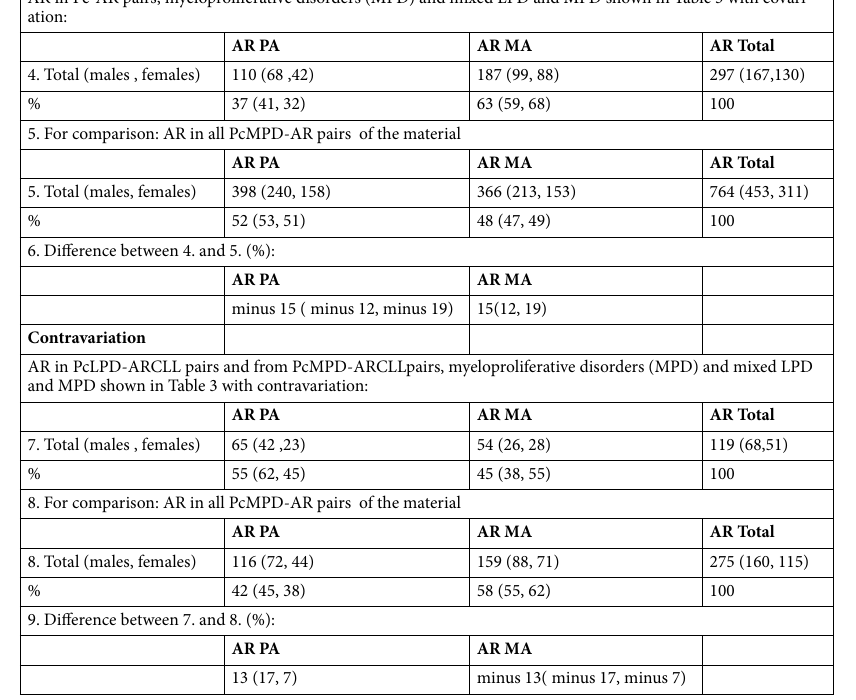
CLL is the most common diagnosis in the continental families (65.6%) compared with a prevalence of 22.8% in the Faroese family. Two of the most common types of malignant lymphoma (FL, follicular lymphoma and DLBCL, diffuse large B-cell lymphoma) have a low prevalence both in the Faroese family (FL 6.4% of all lym- phoproliferative disorders, LPD, and DLBCL 15.6% of all LPD) and in the families from Norway and Denmark (FL 6.9% of all LPD, and DLBCL 5.8% of all LPD). Compared with the findings in the national cancer registries in Norway and Denmark (FL 12% and DLBCL 25% of all LPD) 42,43 , it turns out that the prevalence of both types of malignant lymphoma is significantly lower in the family materials (P < 0.05 for both lymphomas). Anticipation, viz. an increased malignancy down through the generations with a lower age of onset of disease, is pronounced in the Faroese family with a high prevalence of ALL (7.3%) compared with 4% in the Cancer Registries. The mean age at onset of disease is lower than in the continental families (P < 0.01). We are uncertain whether the high incidences of HL and MPD in the Faroese family are signs of anticipation. Birth order effect (BOE) which is a rank order by age of the affected sibs in a sib ship, was s only seen in the Continental families, when male CLL patients in paternal lines appear late in the sib ship (P < 0.001). Segregation of susceptibility to MBD, Continental families. Affected parent – affected offspring pairs (P-O pairs) make up the predominant transgenerational components (Table 1). In 138 P-O pairs (LPD 126 and 12 MPD pairs) extracted from the pedigrees, the diagnoses were either CLL or any other diagnosis within MBD, denoted nonCLL (Table 2). The intention of this set up is to expose CLL versus nonCLL in four P-O groups: CLL – CLL, nonCLL – CLL, CLL – nonCLL and nonCLL – nonCLL .